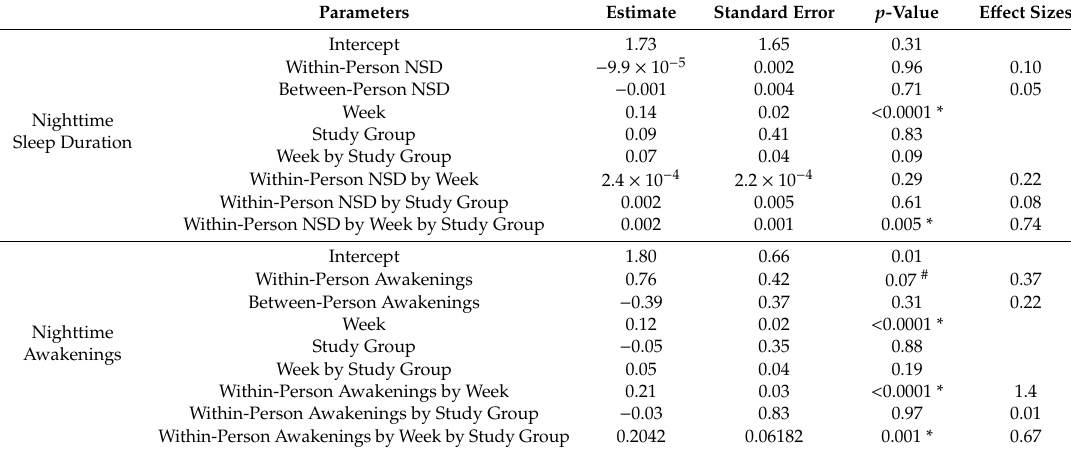
Table 5. Coe ffi cients for the Multilevel Models of Nighttime Sleep Duration and Nighttime Awakenings Predicting Weekly